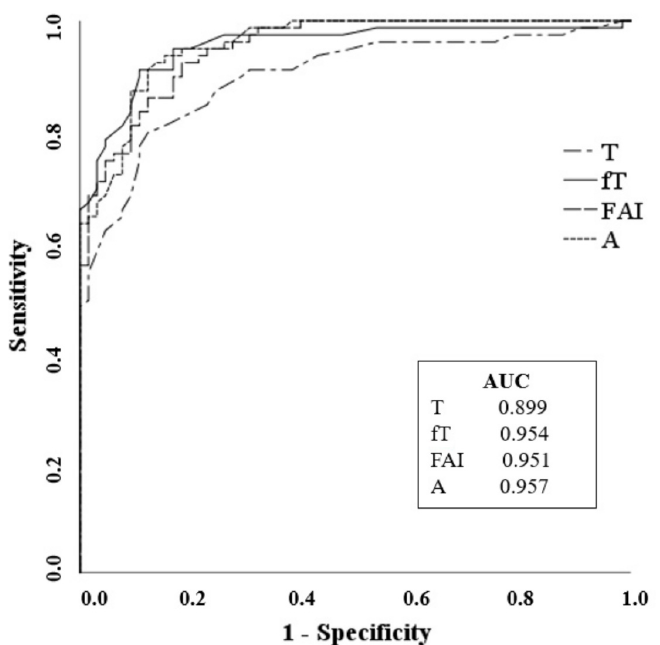
Figure 2. The receiver operating characteristics (ROC) curve analyses of T, fT, free androgen index (FAI), and A measured by LC-MS/MS in discriminating PCOS patients from controls. In PCOS patients, neither A nor T measured by LC-MS/MS correlated with any clinical or metabolic parameters. However, we found a significant correlation between LC-MS/MS fT concentrations and BMI (r = 0.346, p = 0.002), HOMA-index (0.250, p = 0.042), HbA1c (r = 0.337, p = 0.025), and SHGB (r = − 0.353, p = 0.002). In addition, FAI calculated based on LC-MS/MS data was significantly correlated with BMI (r = 0.398, p = 0.001), HOMA-index (r = 0.289, p = 0.016), waist (r = 0.408, p = 0.001), and SHBG (r = − 0.353, p = 0.002). Moreover, SHBG was the biochemical marker that best correlated with the following metabolic parameters: BMI (r = − 0.531, p = 0.001), waist (r = − 0.502, p = 0.001), HOMA-index (r = − 0.468, p = 0.001), HbA1c (r = − 0.300, p = 0.046), and hirsutism severity (r = − 0.404, p =